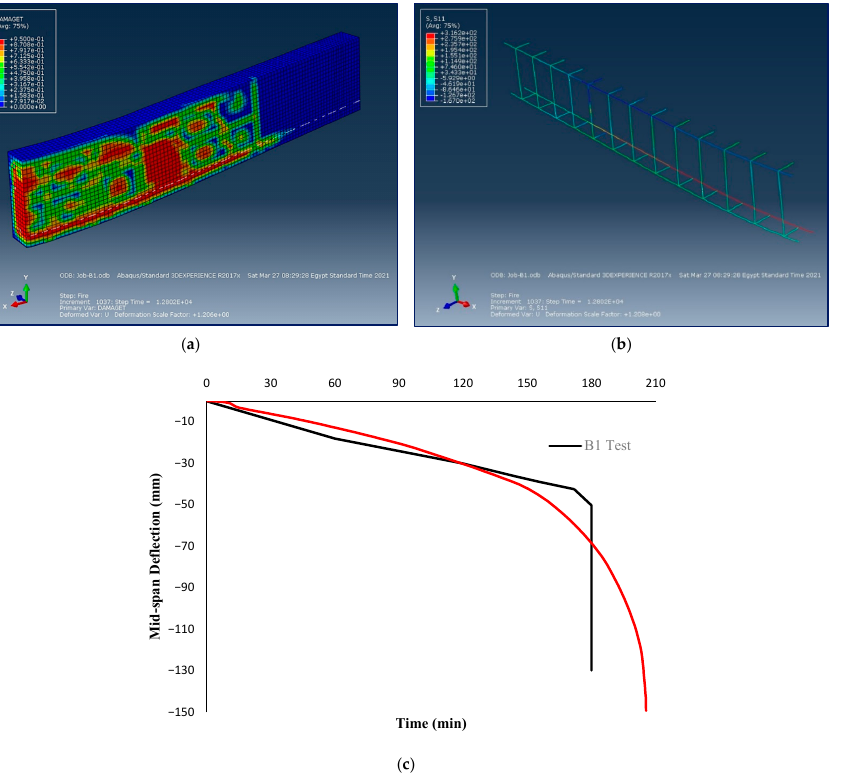
Figure 8. B1 Structural response: ( a ) failure crack pattern, ( b ) reinforcement stress failure, and ( c ) mid ‐ span vertical displacement.